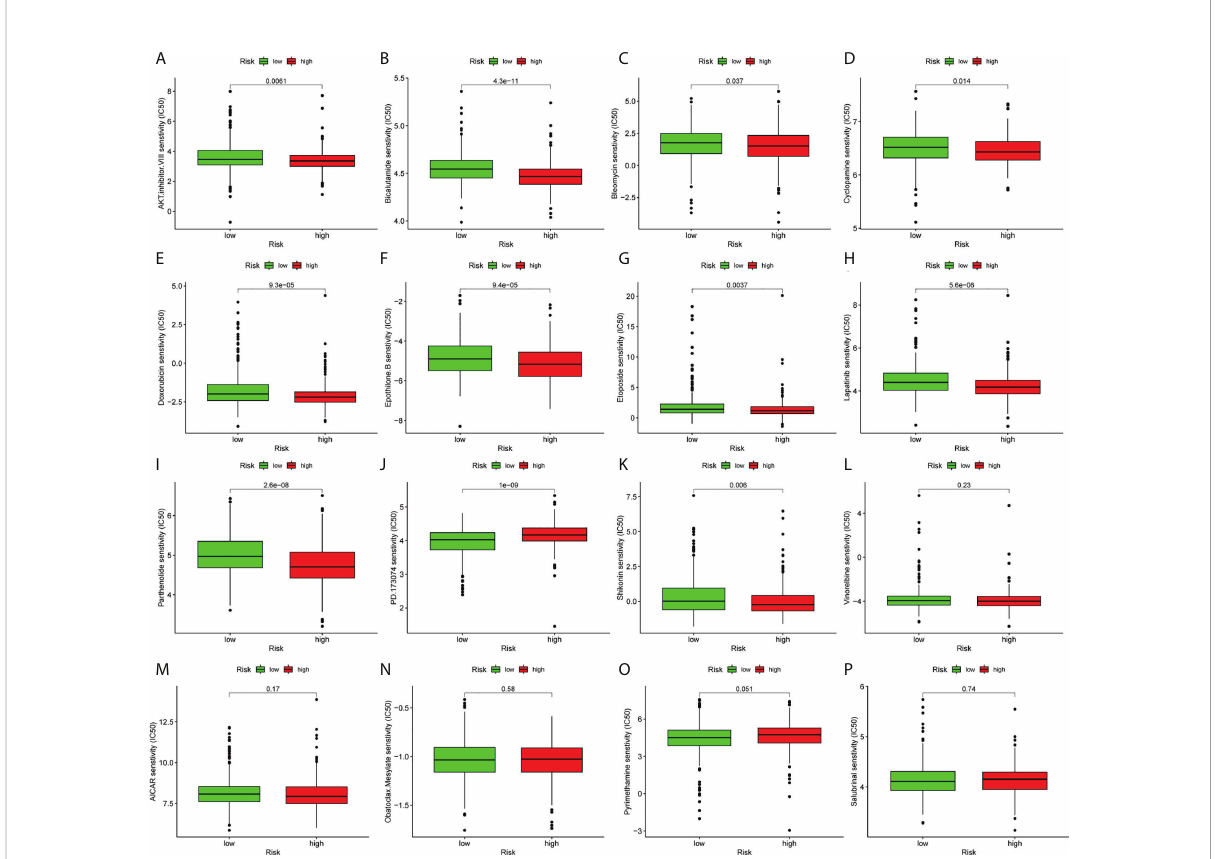
FIGURE 8 Prediction of response to common chemotherapeutic drugs between the low- and high-risk groups. (A – P) Patients in the high-risk group (n=267) exhibited higher estimated half-maximal inhibitory concentration compared with patients in the low-risk group